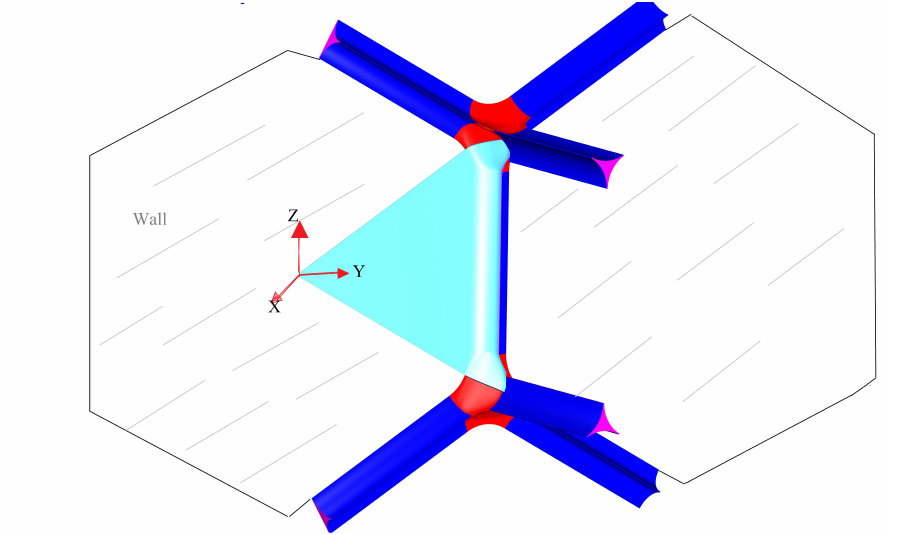
Figure A2. The exterior foam is in contact with the wall, as indicated by the bubbles touching the wall in the ZX